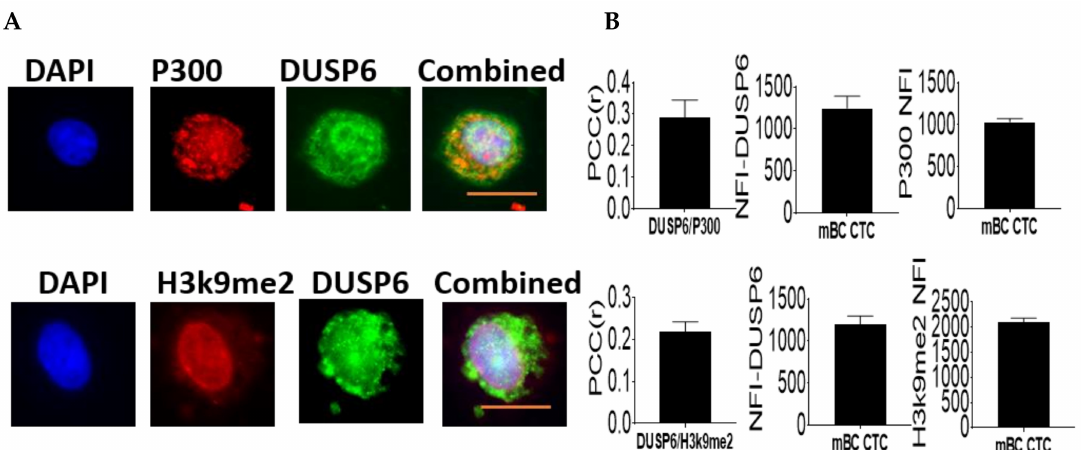
Figure 5. Nuclear DUSP6 interaction with P300 or H3k9me2. Confocal laser scanning microscopy was performed on CTCs (circulating tumor cells) isolated from metastatic breast cancer patients (Stage IV n = 10). Cells were fixed and probed with primary rabbit antibodies to DUSP6 and primary mouse antibodies to P300 or H3k9me2 followed by the corresponding secondary antibody conjugated to Alexa-Fluor 568 or Alexa-Fluor 488. Representative images for each antibody dataset pair are shown: red = p300 or H3k9me2; green = DUSP6. ( A ) The The Pearson correlation coe ffi cient (PCC) was determined as described in methods. PCC indicates the strength of relation between the two fluorochrome signals for at least 20 individual cells ± SE. Bar graphs ( B ) indicate the total NFI of DUSP6, p300, or H3K9me2 as measured using ASI software to select the nucleus of each cell and measure the total NFI signal minus background for at least 20 individual cells ± SE. Scale bar is in orange and equals 10 µ